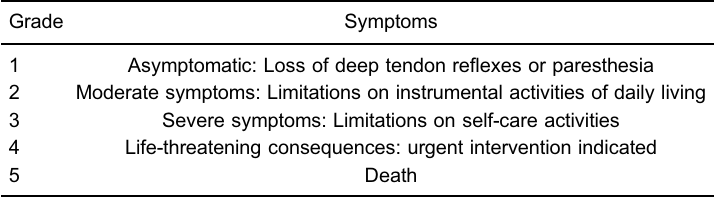
Table 1. Peripheral neuropathy grading criteria according to the National Cancer Institute, version 4.0.